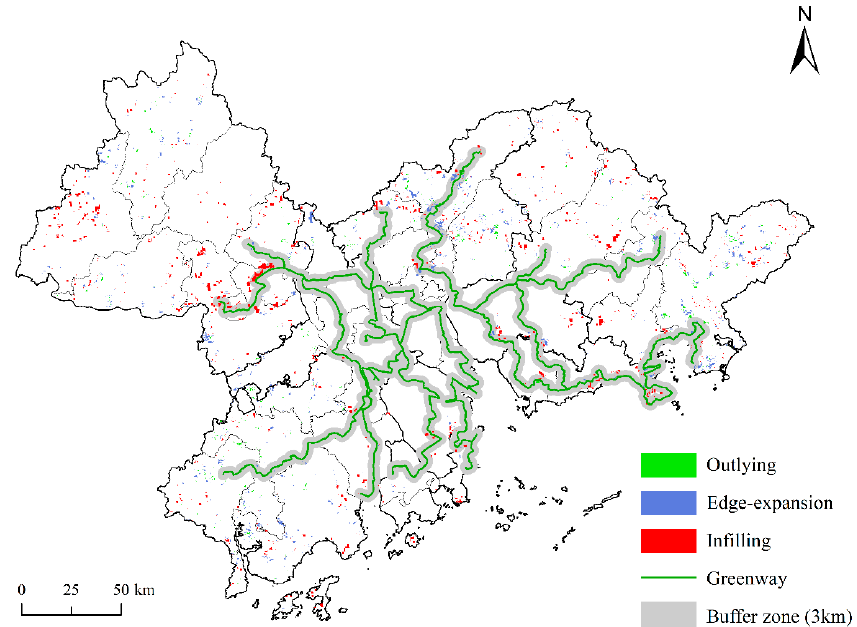
Figure 4. Ecological land restoration patterns within the 3-km buffer zone of the greenway.